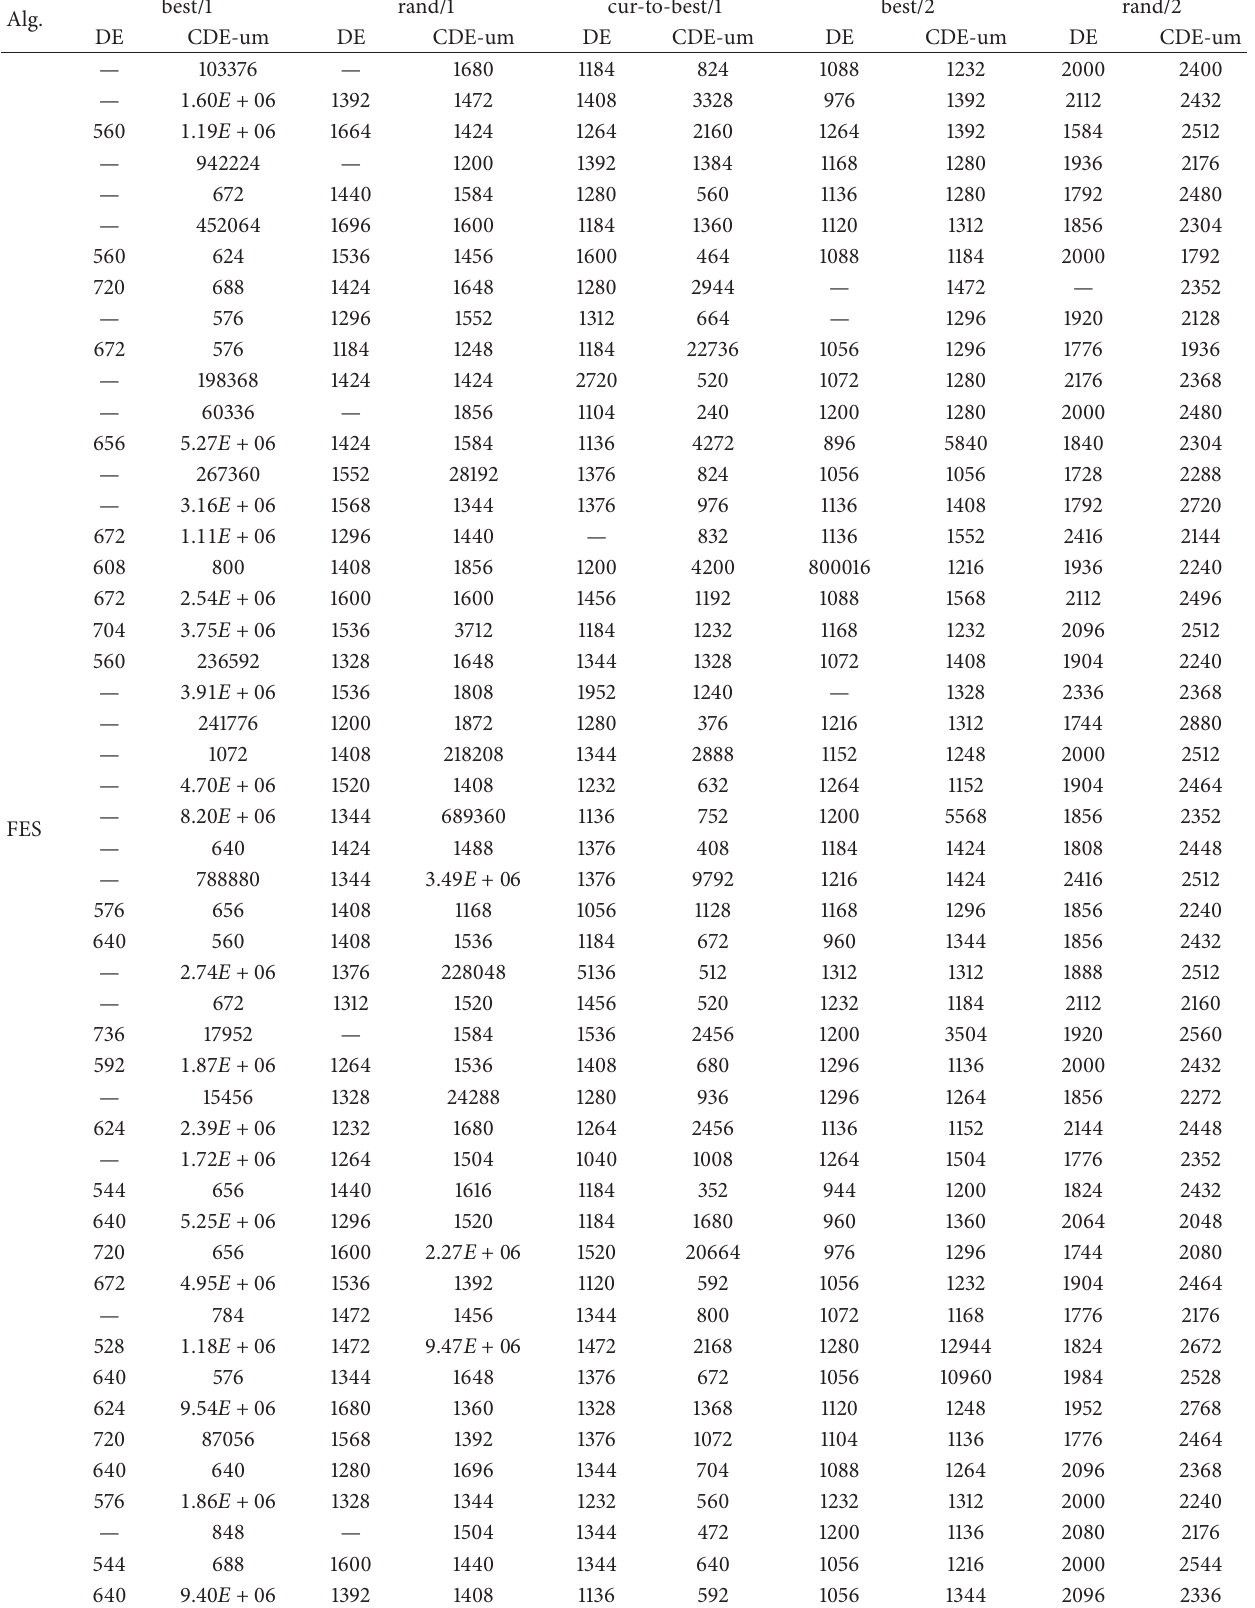
Table 2: FES to achieve the Ter Err for Rastrigin